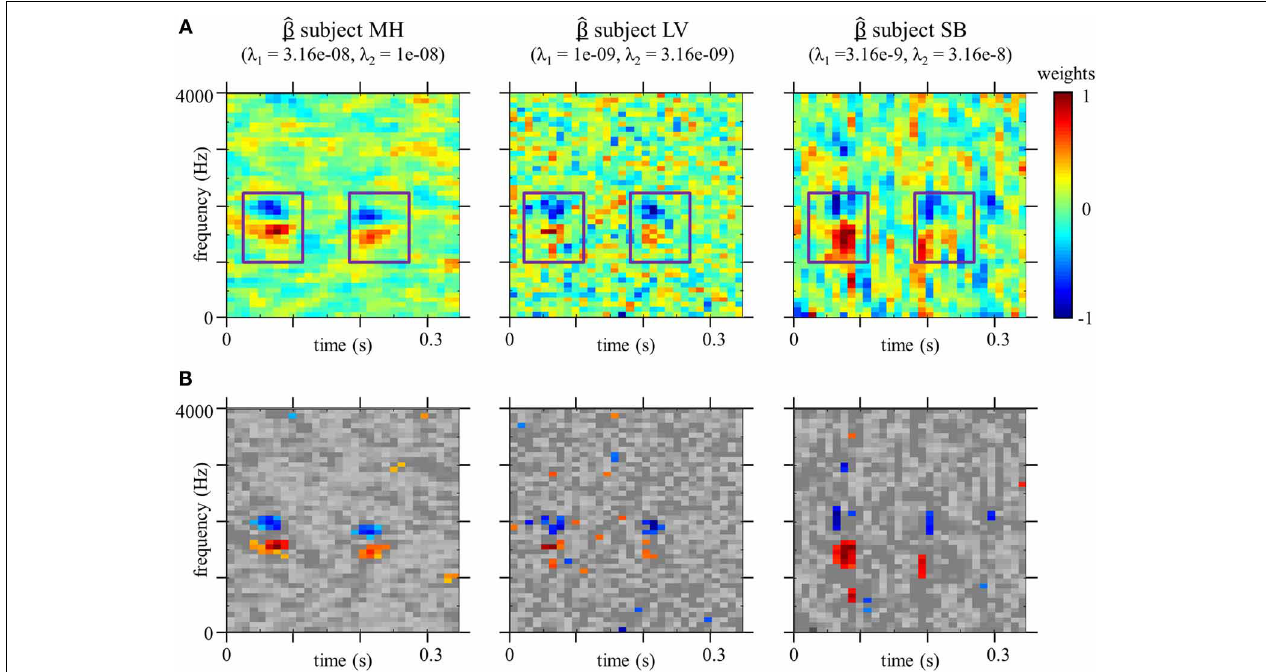
corresponds to the position of the second formantic transition (F2) in the original stimuli spectrograms. (B) Same as above except that non-significant weights are shown in gray scale ( p < 0 . 005, permutation test).